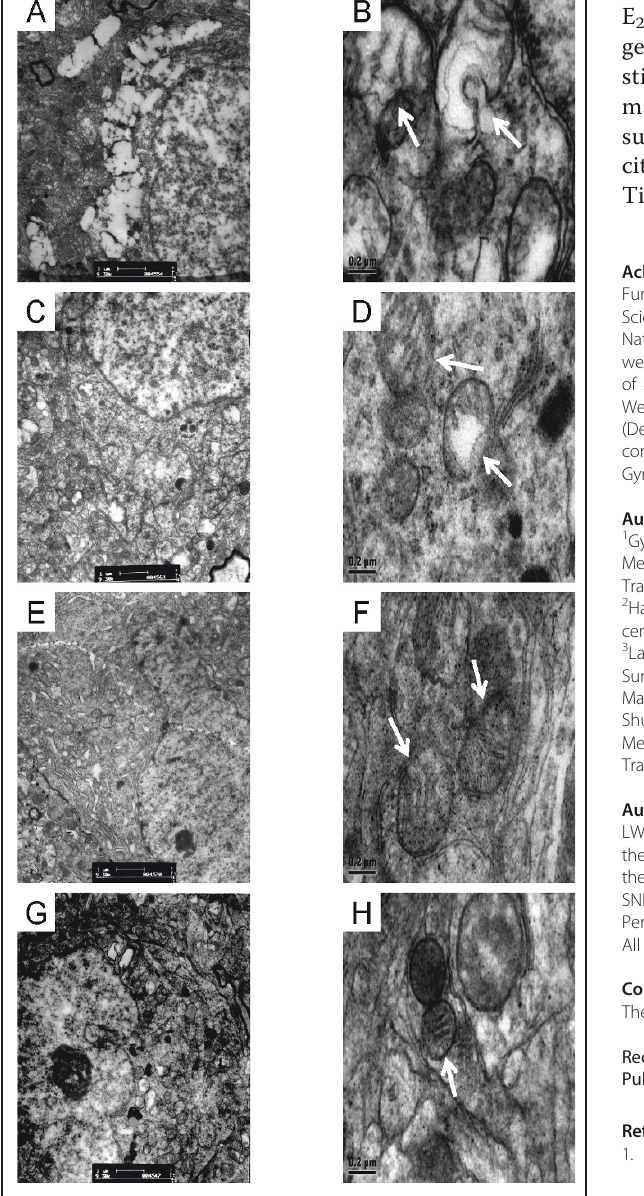
Figure 4 Ultrastructural mitochondria alteration . Ultrastructure of mitochondria of hypothalamic neurons in untreated (control), Premarin-treated, and TGT-treated ovariectomized rats, and in non- ovariectomized rats, under electron microscopic magnification of 8,200 (A, C, E, G) and 43,000 (B, D, F, H). Mitochondrial damage is indicated by